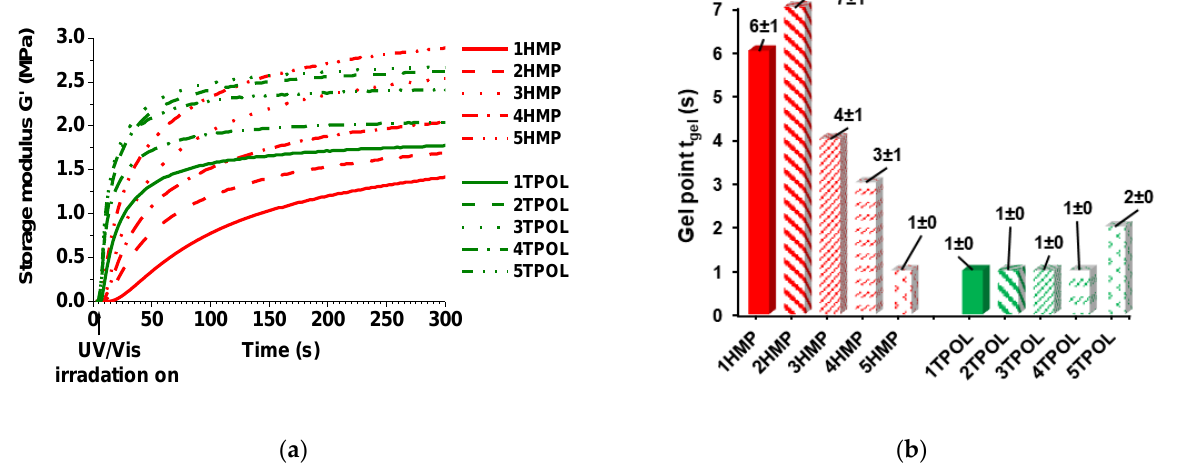
Figure 2. ( a ) Curves of storage modulus G ′ versus irradiation time of the compositions with different photoinitiators, ( b ) Gel point of AESO thiol – ene resins.